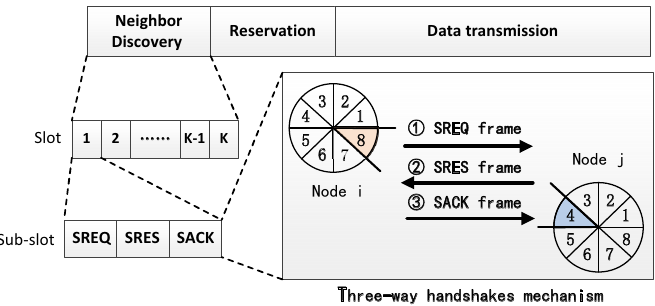
Figure 3. Directional transmission and reception algorithm (DTRA) method and the process of three-way handshakes mechanism.